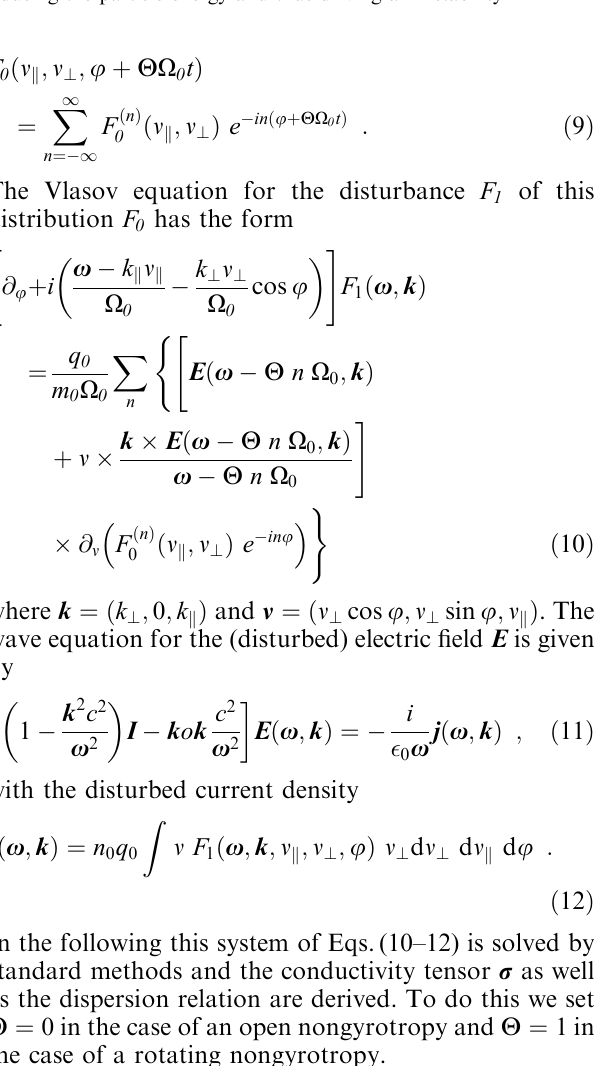
Fig. 4. a,b. Particle di(cid:128)usion into an undercrowded gyrophase sector. a di(cid:128)usion process conserving the particle energy; b di(cid:128)usion process reducing the particle energy and thus driving